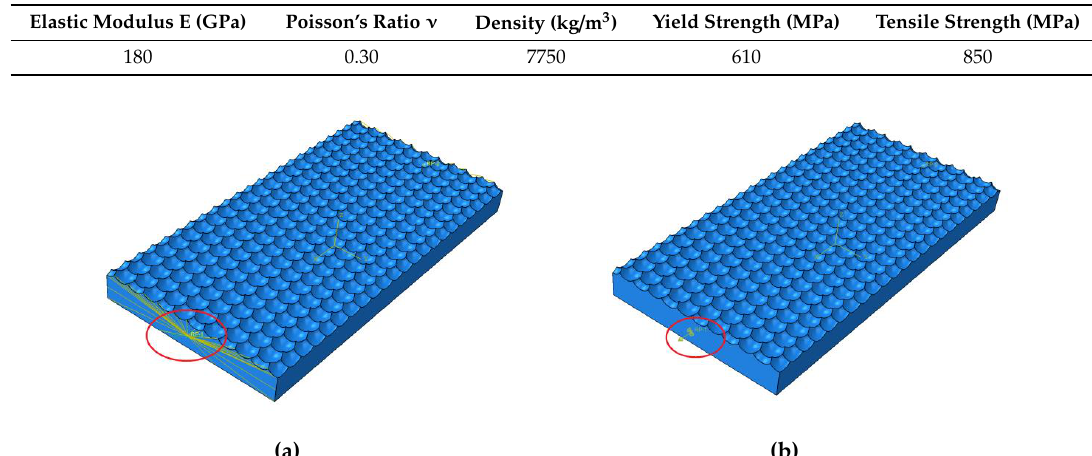
Table 1. Chemical composition of Cr12MoV hardened steel [31].